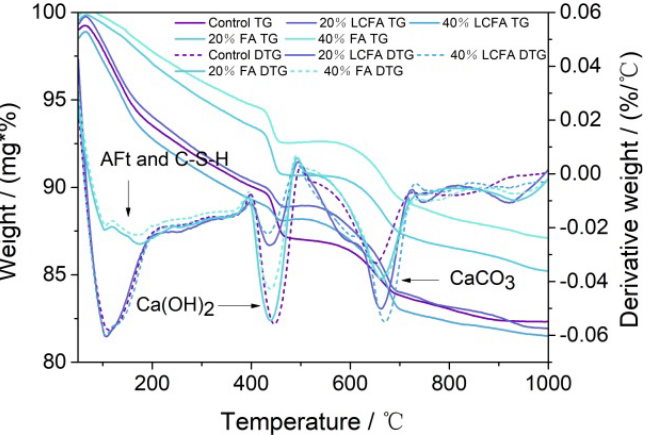
Figure 14. TG and DTG analysis of OPC-LCFA and OPC-FA sample at 28 days.